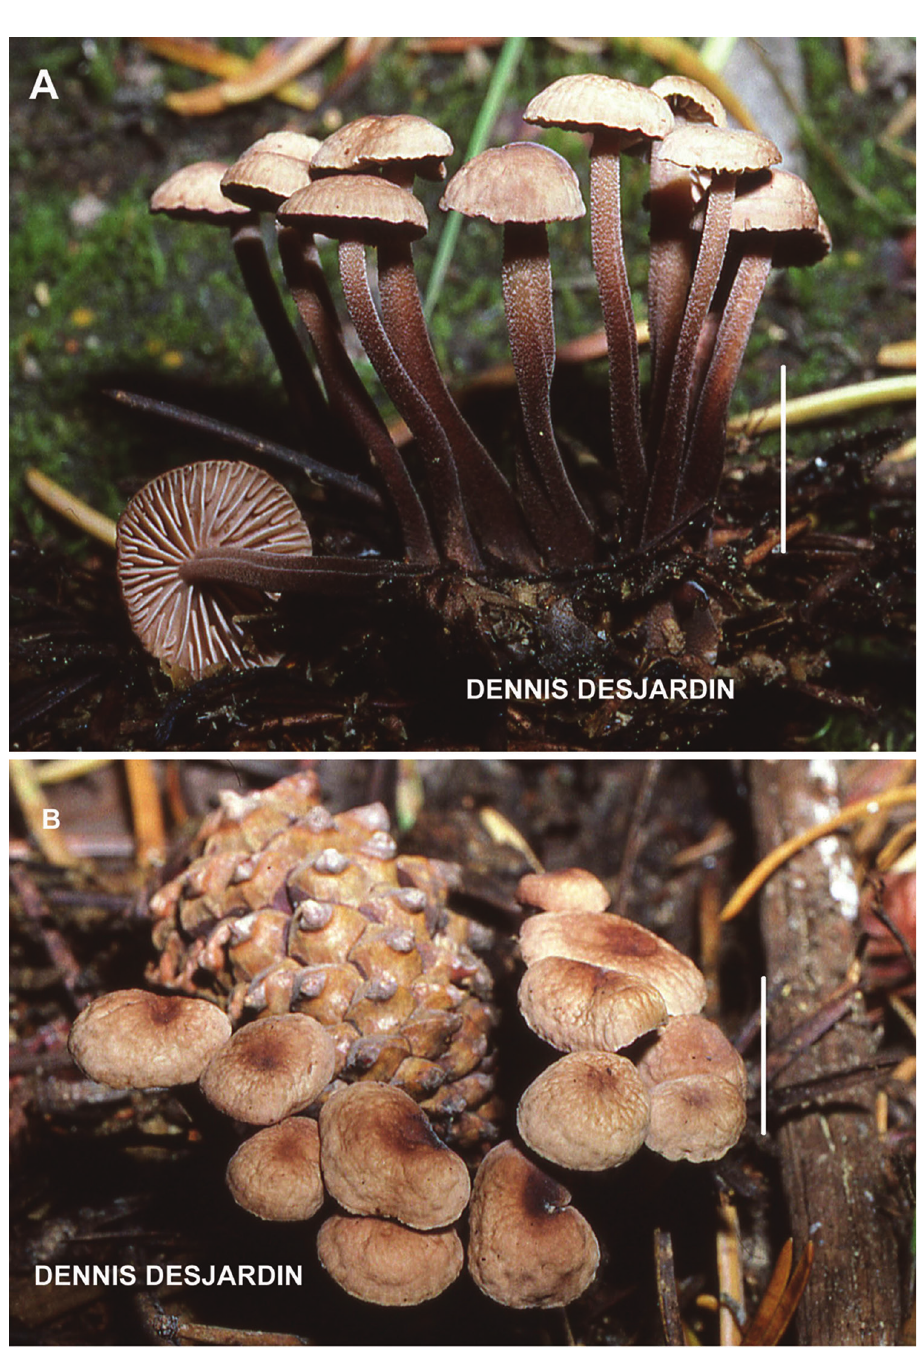
Figure 11. Mycetinis applanatipes . Basidiomata. Standard bars = 10 mm. DED 2330 (SFSU). Courtesy Dennis